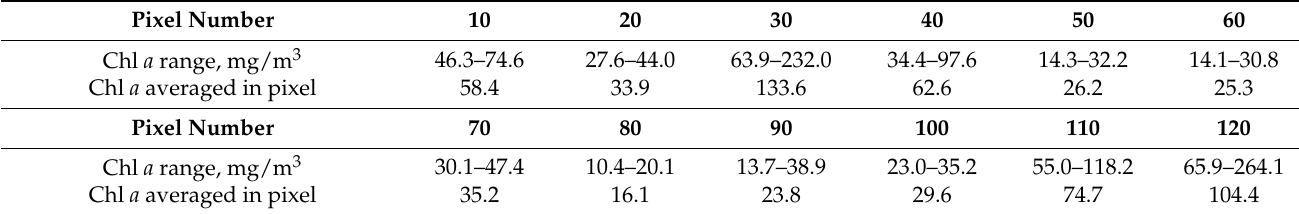
Table 1. Concentrations of Chl a along the motorboat